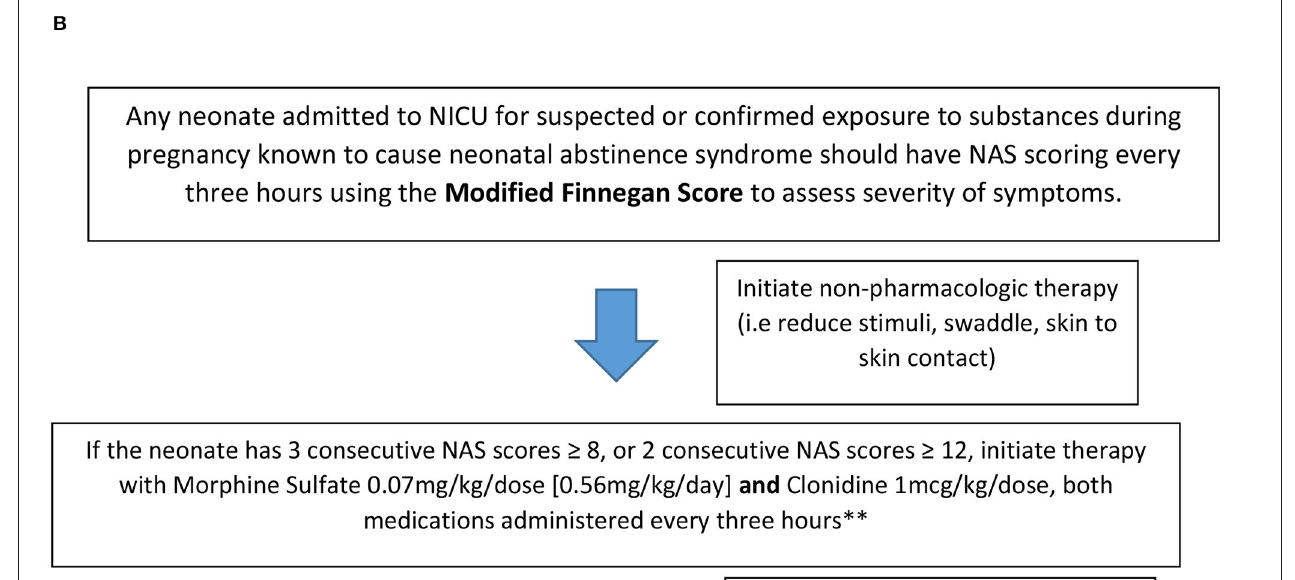
FIGURE 1 | Neonatal Abstinence Syndrome Treatment Algorithm. (A) Group 1 pre-implementation Neonatal Abstinence Syndrome Treatment Algorithm (2/2014). (B) Group 2 Post-implementation BUMC-T Neonatal Abstinence Syndrome Treatment Algorithm (8/2016).